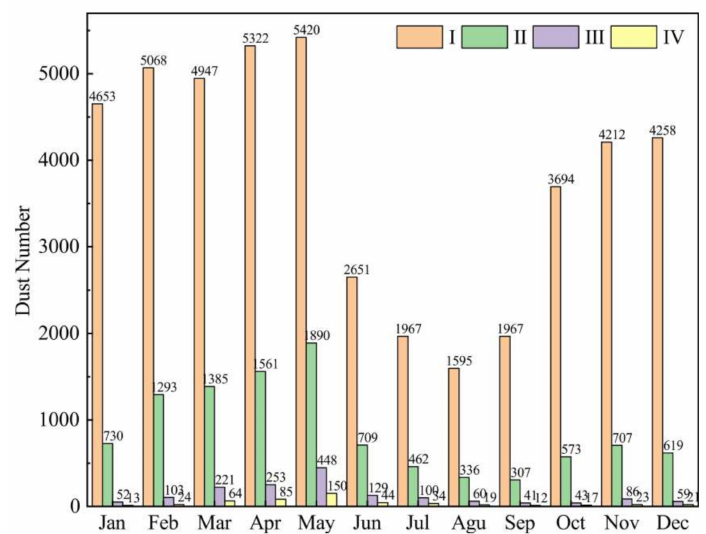
Figure 5. Monthly change of the dust event frequencies for different levels from 2015 to 2020.